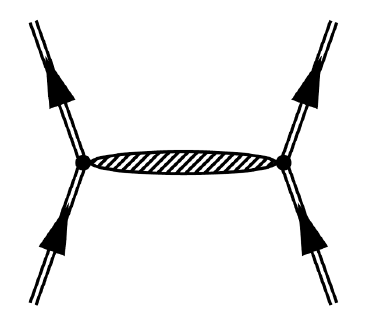
Figure 1. A schematic Feynman diagram for a general neutrino propagation process. The double lines show the external states at the production and detection vertices. The elliptical blob symbolises the Källén-Lehmann propagator. In the case of canonical oscillations, this reduces to the usual Feynman